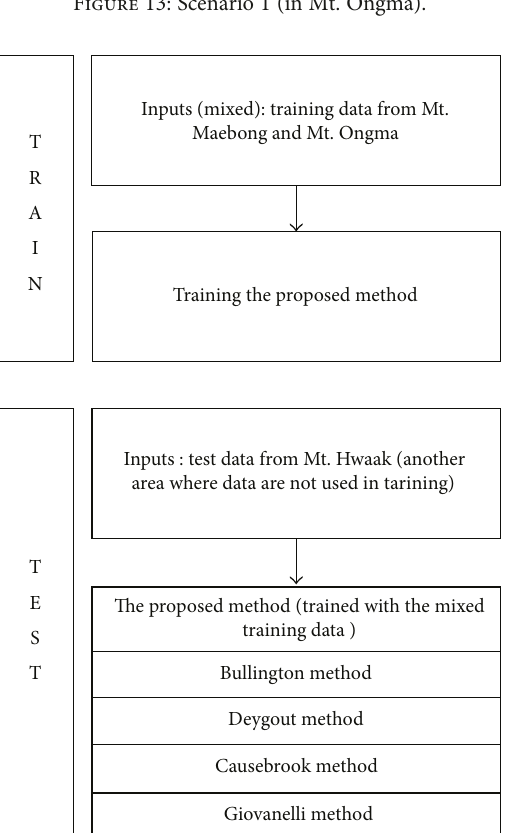
Figure 14: Scenario 2 (in Mt.